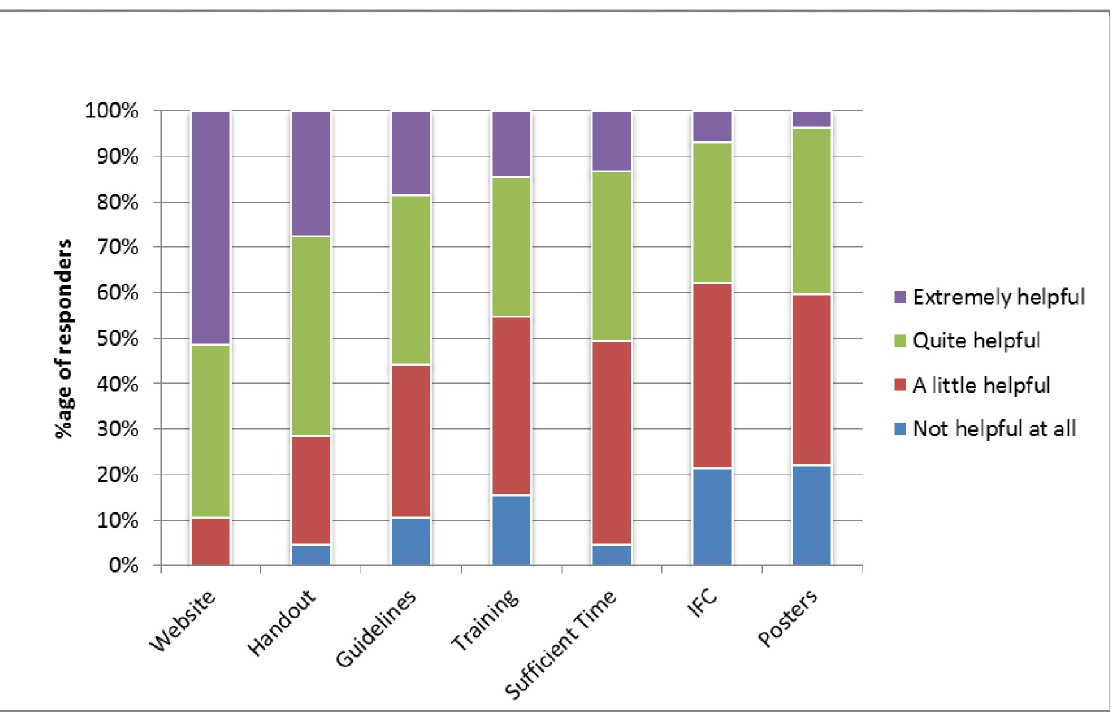
Fig 4. Strategies to facilitate discussion of out-of-pocket (OOP) costs in the clinic. � IFC = Standard for Informed Financial